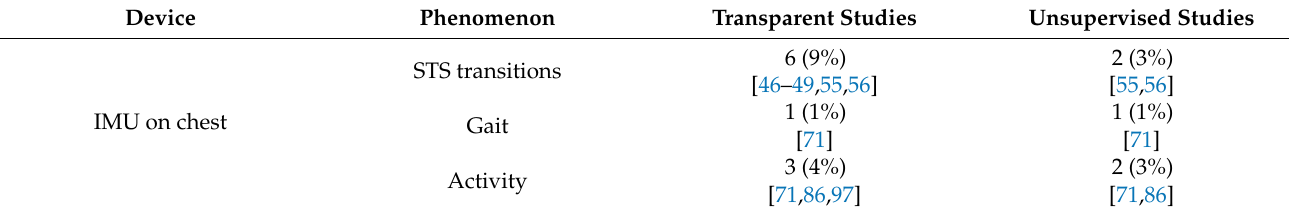
Table 8. Number of studies in unsupervised conditions (right column) and number of studies relying on transparent activities (second column on the right) for different types of devices (left column) and phenomena (second column on the left). The figures in square brackets are the citations for the corresponding studies. The figures in brackets represent the percentage with respect to all 67 studies in the review. Note that the studies in the unsupervised column are a subset of the studies in the transparent column. The IMU on the thigh in the last row is the only non-transparent sensor tested in unsupervised